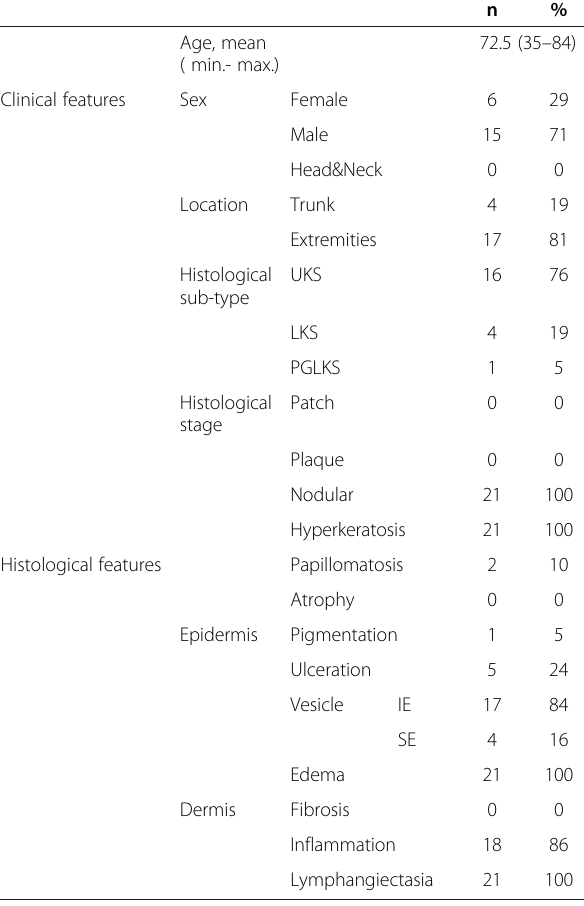
Table 1 Clinicopathological features of Kaposi sarcoma cases showing vesicular morphology (n=